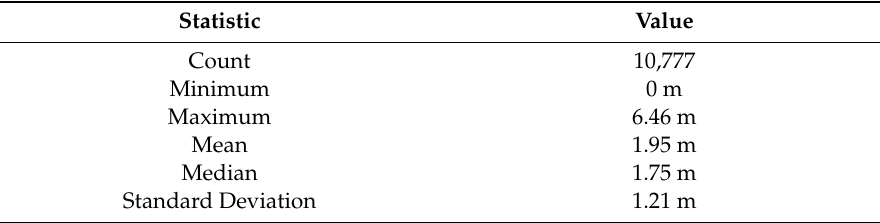
Table 1. Summary statistics for well minimum depth-to-water data included in the analysis.